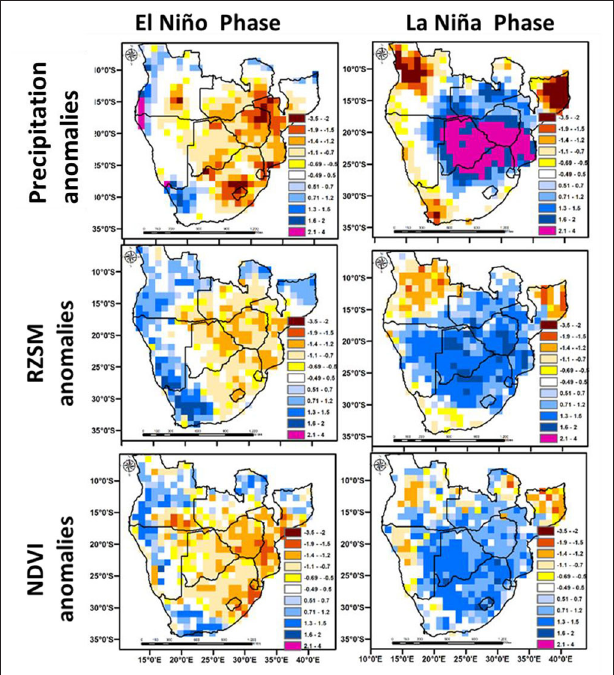
FIGURE 4 | Standardized precipitation, root-zone soil moisture and NDVI anomalies at peak El Niño (top) condition from November 2015 to January 2016 and La Niña condition (bottom) from November 2016 to January 2017 in Eastern